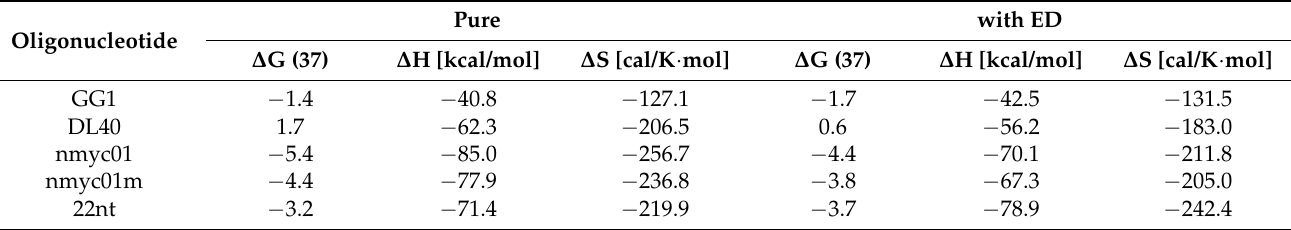
Table 3. Thermodynamic parameters for the folding process in the absence and presence of escholidine. These values were determined from the CD-monitored melting experiments assuming a two-state process and null constant values of the changes in enthalpy and entropy through the melting process. The associated uncertainties are 5% for ∆ H and ∆ S and 10% for ∆ G.